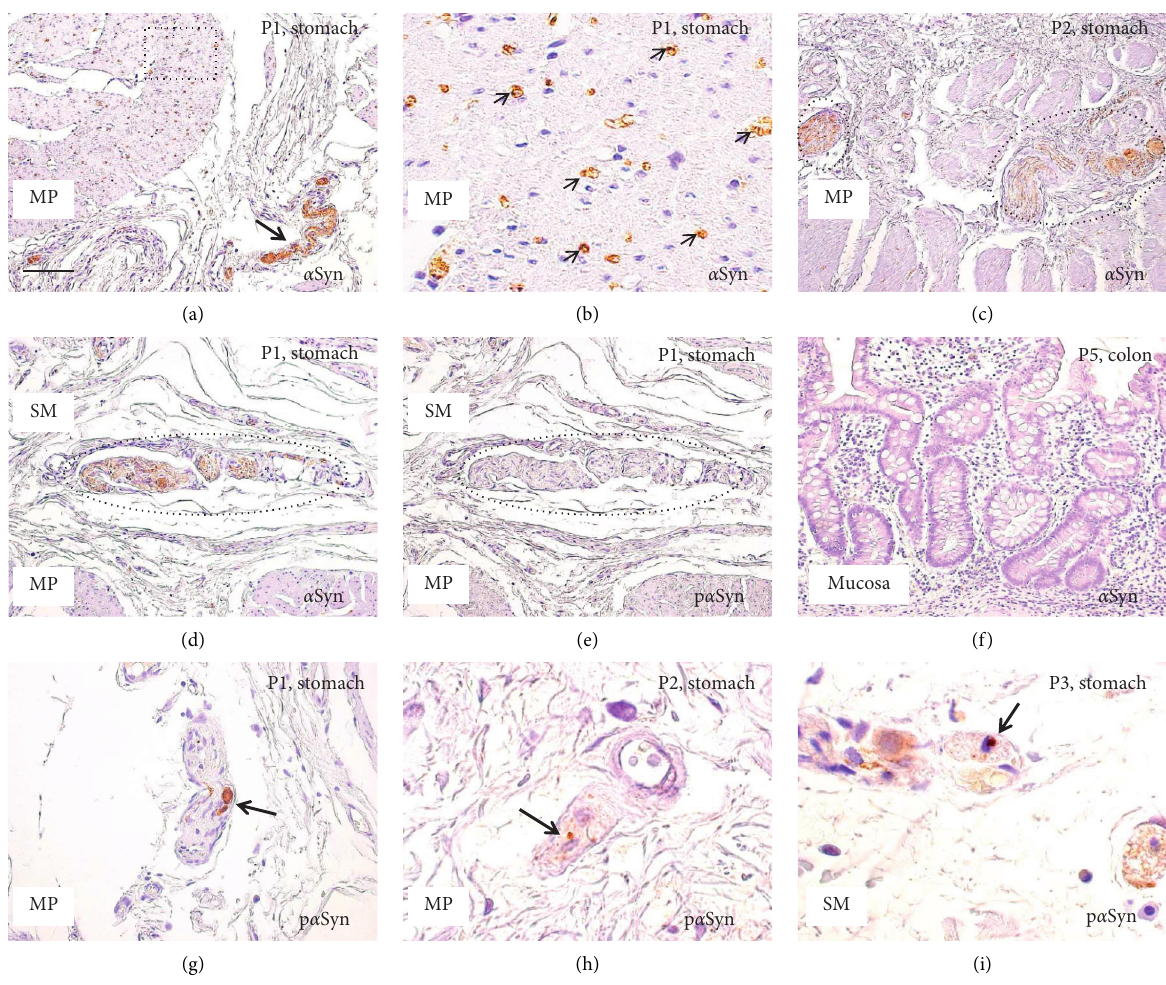
Figure 2: Immunohistochemical analyses of patients with premotor PD. Immunohistochemistry for α -synuclein ( α Syn) (a–d, f), and phosphorylated α -synuclein (p α Syn) (e, g–i). (a, b, d, e, g) Sections of the stomach of patient P1; (c, h) sections of the stomach of patient P2; (f) section of the colon of patient P5; (i) sections of the stomach of patient P3. (b) High magnification view of the dotted square in (a, d, e) are